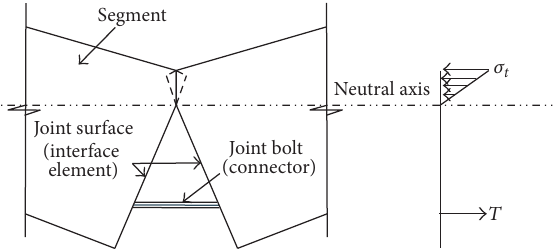
Figure 5: Mechanical behavior and theoretical model of the seg- mental